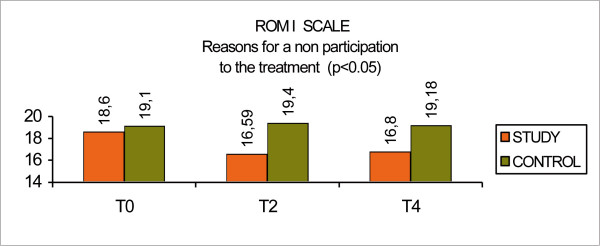
ROMI scale: reasons for non participating.